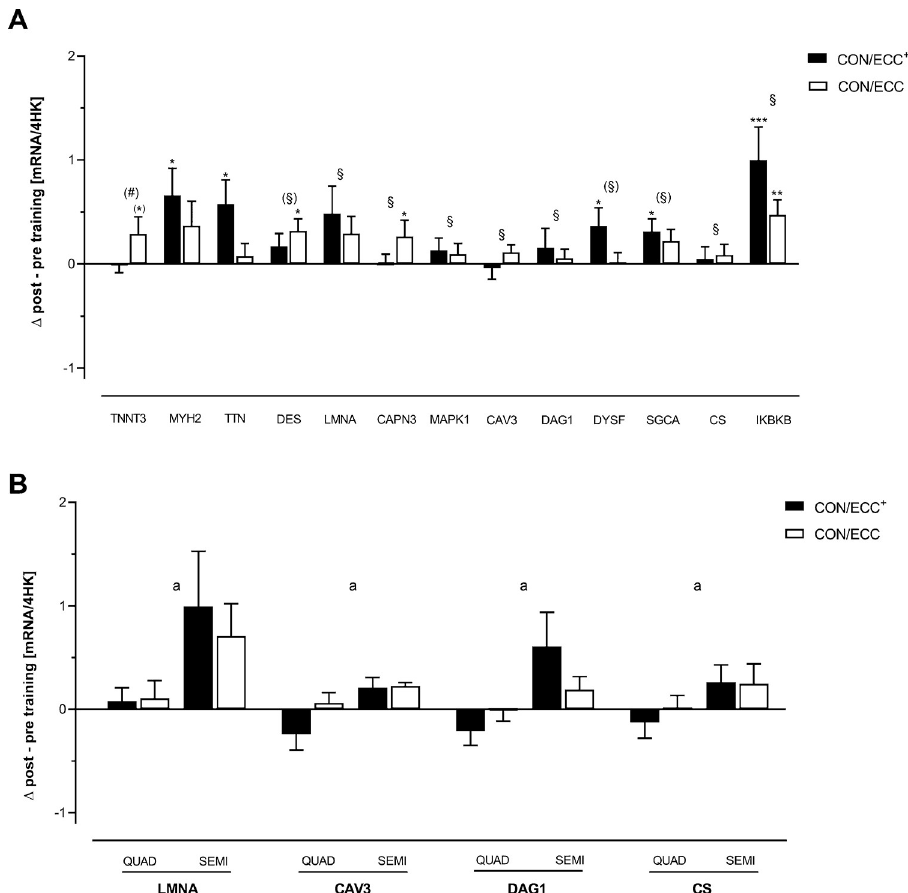
Fig 3. A. Significantly changed marker mRNAs encoded by genes involved in skeletal muscle contractility. B. Significantly changed marker mRNAs encoded by genes involved in skeletal muscle contractility significantly affected by the type of autograft. These are relative values based on an aggregate of 4 housekeeping (HK) transcripts. Mean ± SE are shown. (#): Tendency (p = 0.053) towards a group x time effect; §: Significant time effect (p < 0.05); (§): Tendency (DES: p = 0.066; DYSF: p = 0.062; SGCA: p = 0.067) towards a time effect; � : p < 0.05, �� : p < 0.01 compared to the respective baseline value; ( � ): Tendency (p = 0.052) for a difference compared to the respective baseline value; a: Significant (p < 0.05) effect of the type of